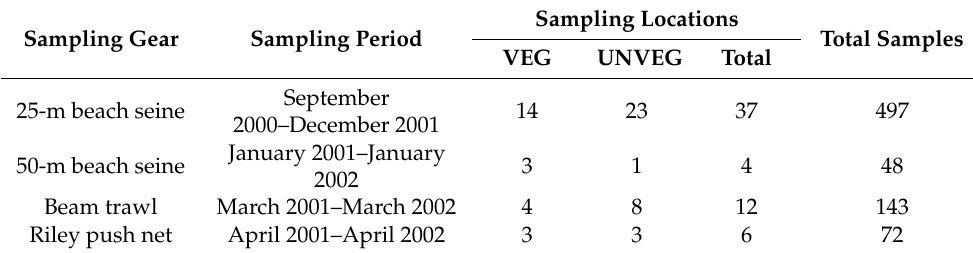
Table 1. Sampling periods, numbers of vegetated (VEG) and unvegetated (UNVEG) sampling locations, total number of sampling locations and total numbers of samples for each gear (number of sampling locations x number of months where sampling occurred). Due to logistic problems, sampling did not take place every month in all sampling